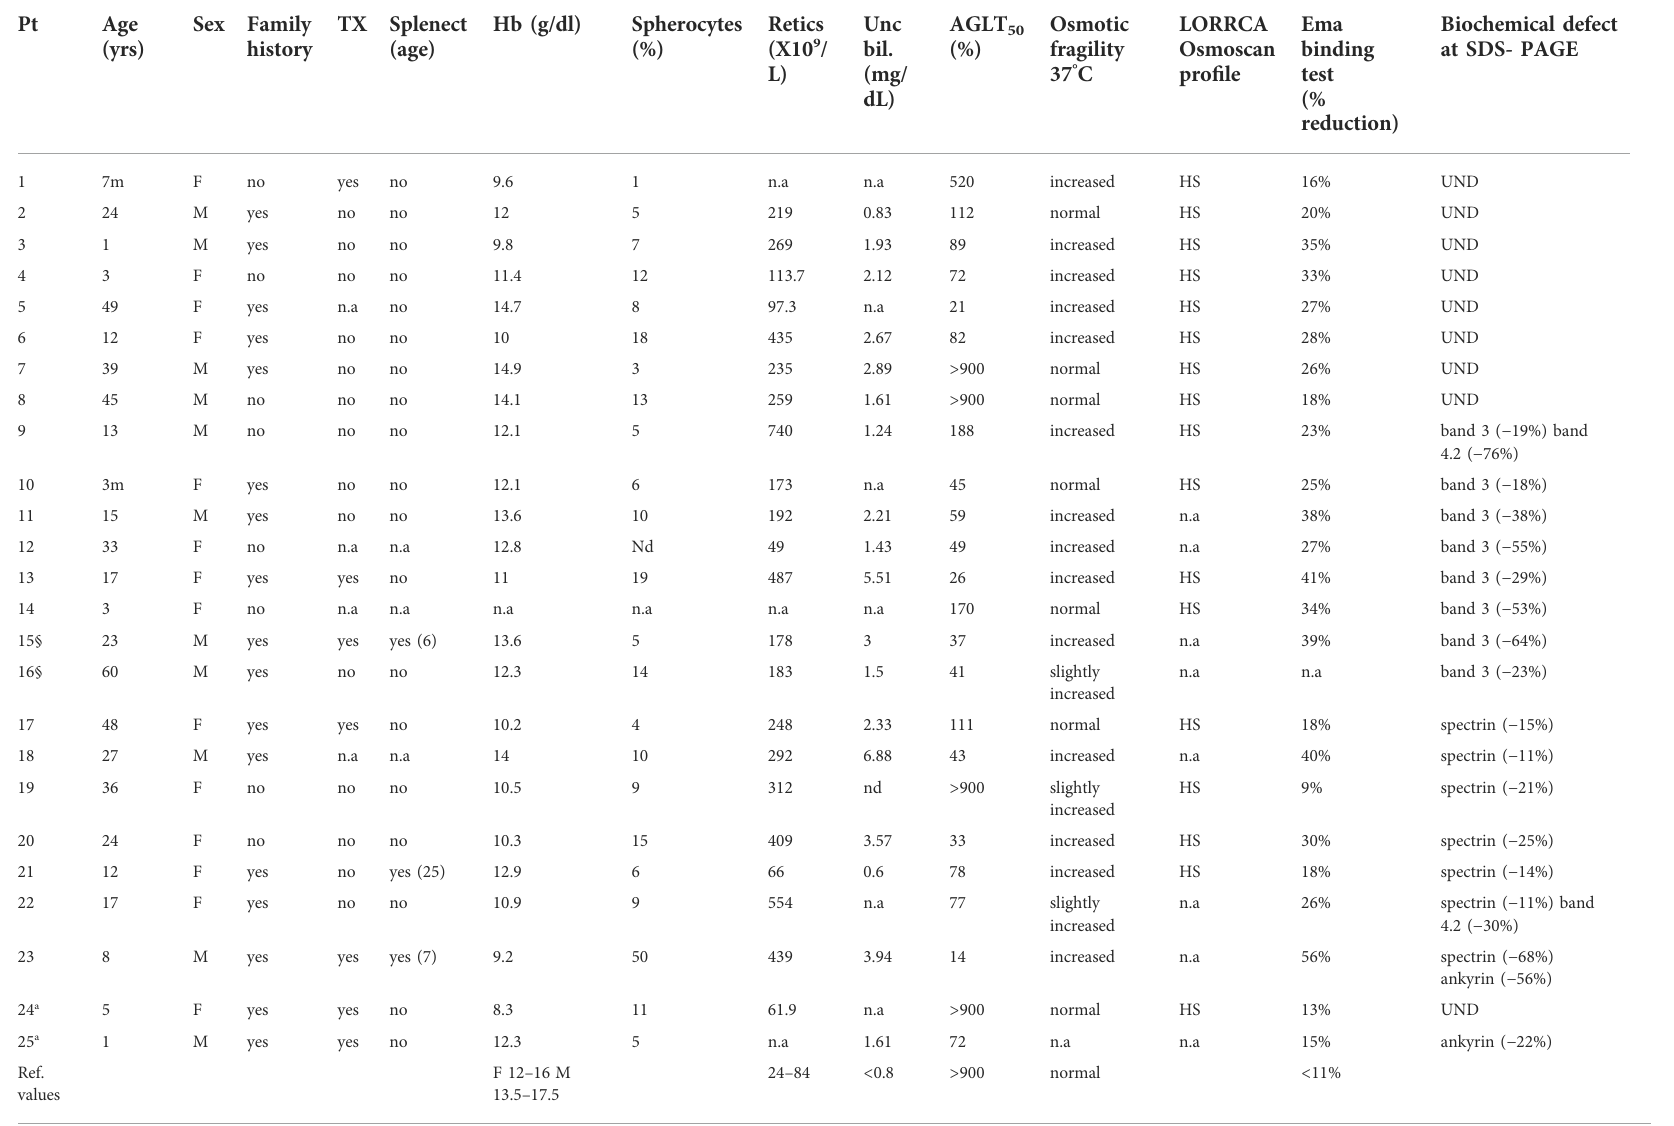
TABLE 1 Clinical and laboratory characteristics of the 25 HS patients at the time of